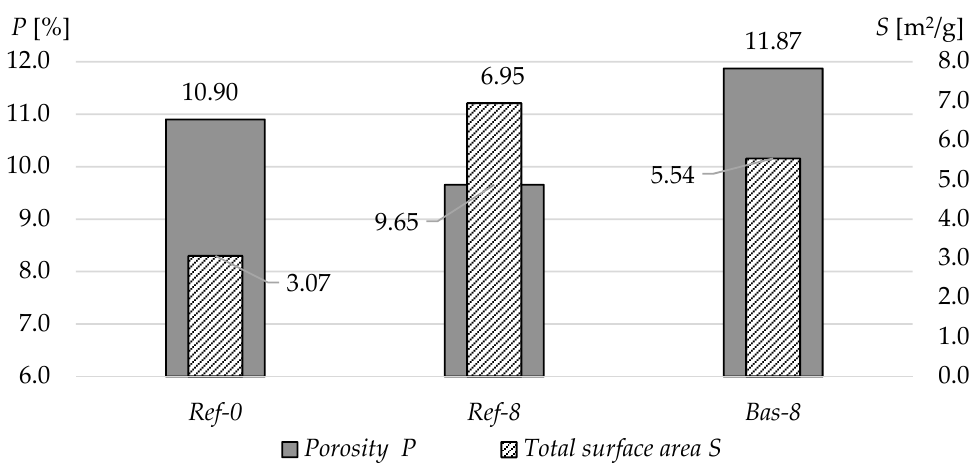
Figure 5. Porosity and total surface area of the tested concretes measured by means of mercury porosimetry.